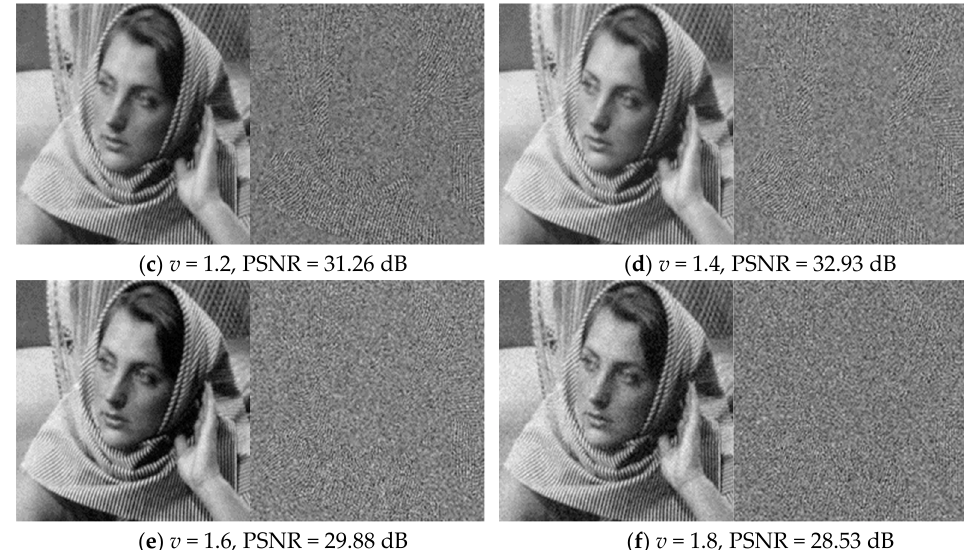
Figure 3. Reconstructed images (Barbara) and the residual images with various fractional order v , the sampling ratios is equal 30%.